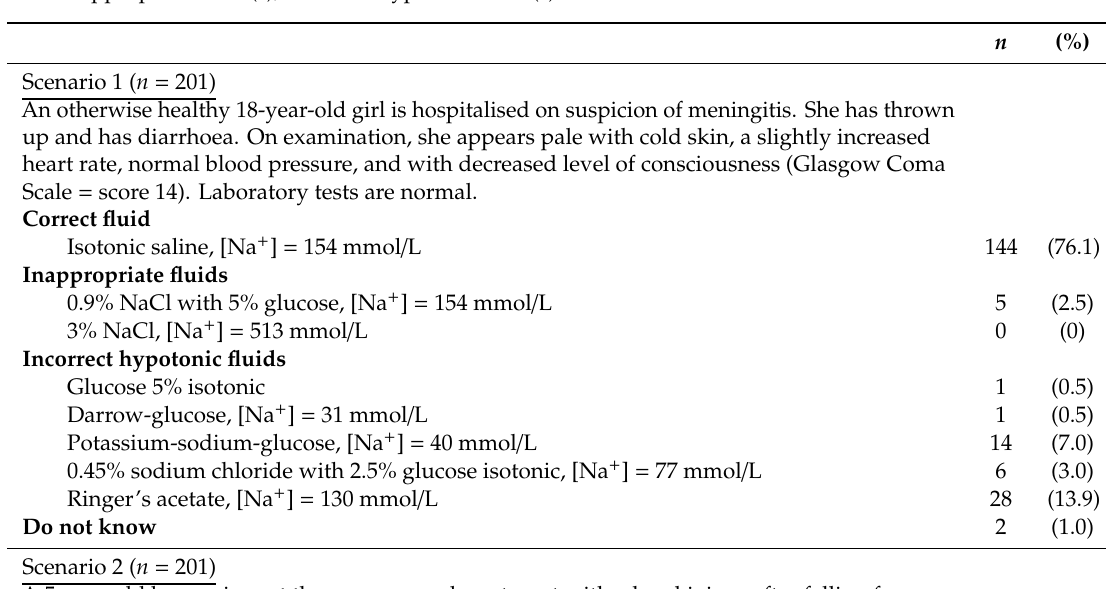
Table 3. Percentage of correct responses of prescribing practice in four clinical scenarios encountered in the emergency department. Responses are grouped into four categories, selection of correct fluid(s), inappropriate fluid(s), incorrect hypotonic fluid(s) and ‘do not